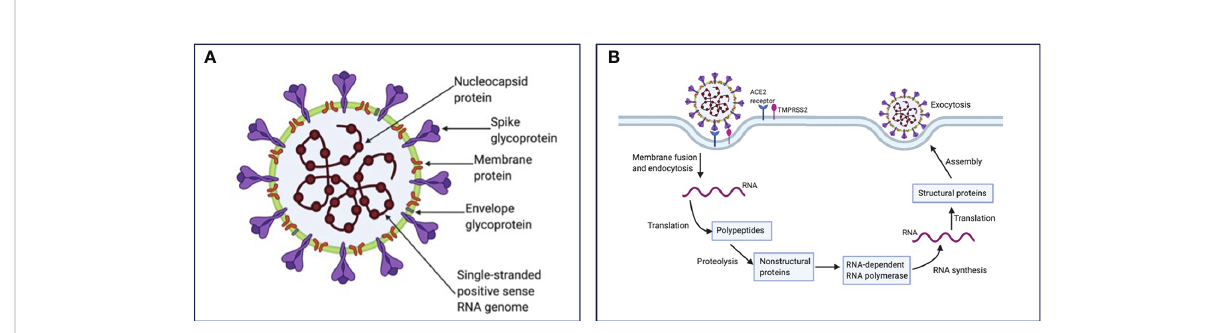
FIGURE 1 SARS-CoV-2 structure and life cycle. (A) SARS-CoV-2 contains four structural proteins: spike surface glycoprotein, membrane, nucleocapsid and envelope protein, as well as eight accessory proteins (not represented). (B) Coronavirus particles bind to cellular attachment factors and speci fi c S interactions with the cellular receptors ACE2 and TMPRSS2, promoting viral uptake and membrane fusion. Positive sense single- stranded RNA is released, partially translated into SARS-CoV-2 polymerase protein, and transcribed. Structural proteins and accessory proteins (N, S, M, and E) results after RNA subgenomic translation, that are inserted into the ER – Golgi compartment for virion assembly. Subsequent positive-sense RNA genomes are incorporated into newly virions, which are secreted from the plasma